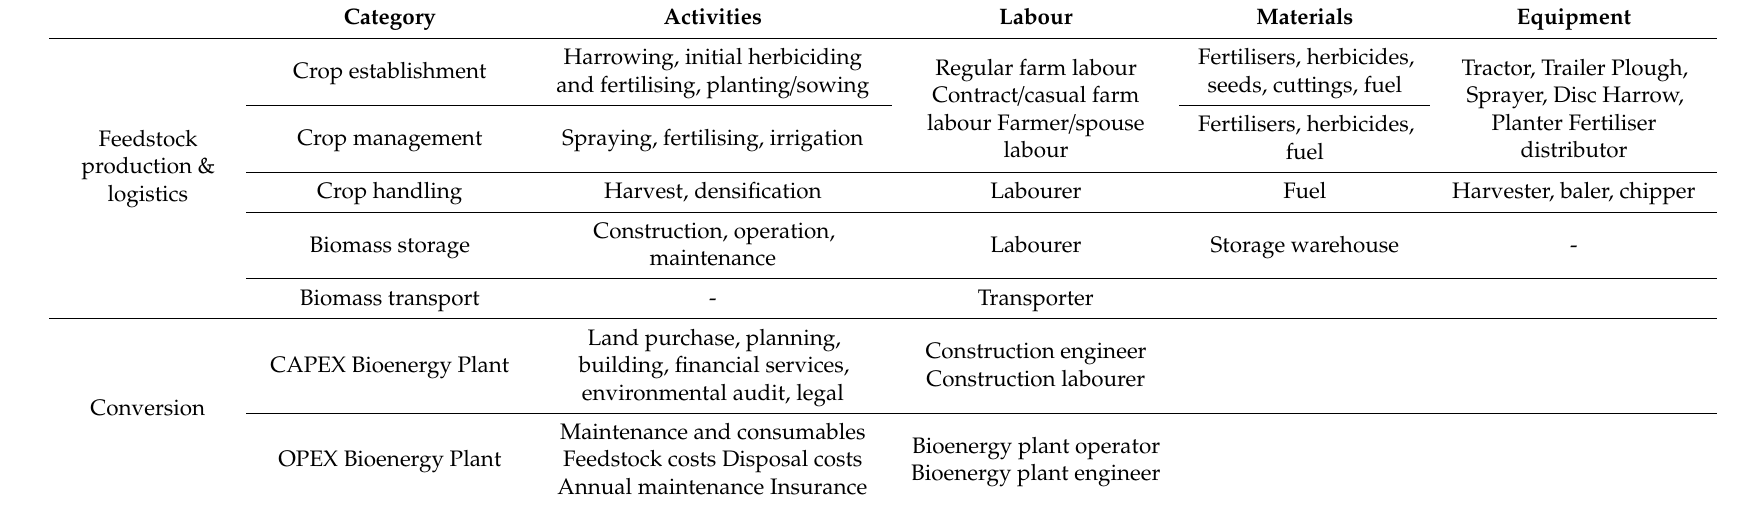
Table 3. Input Output tables used in the modelling